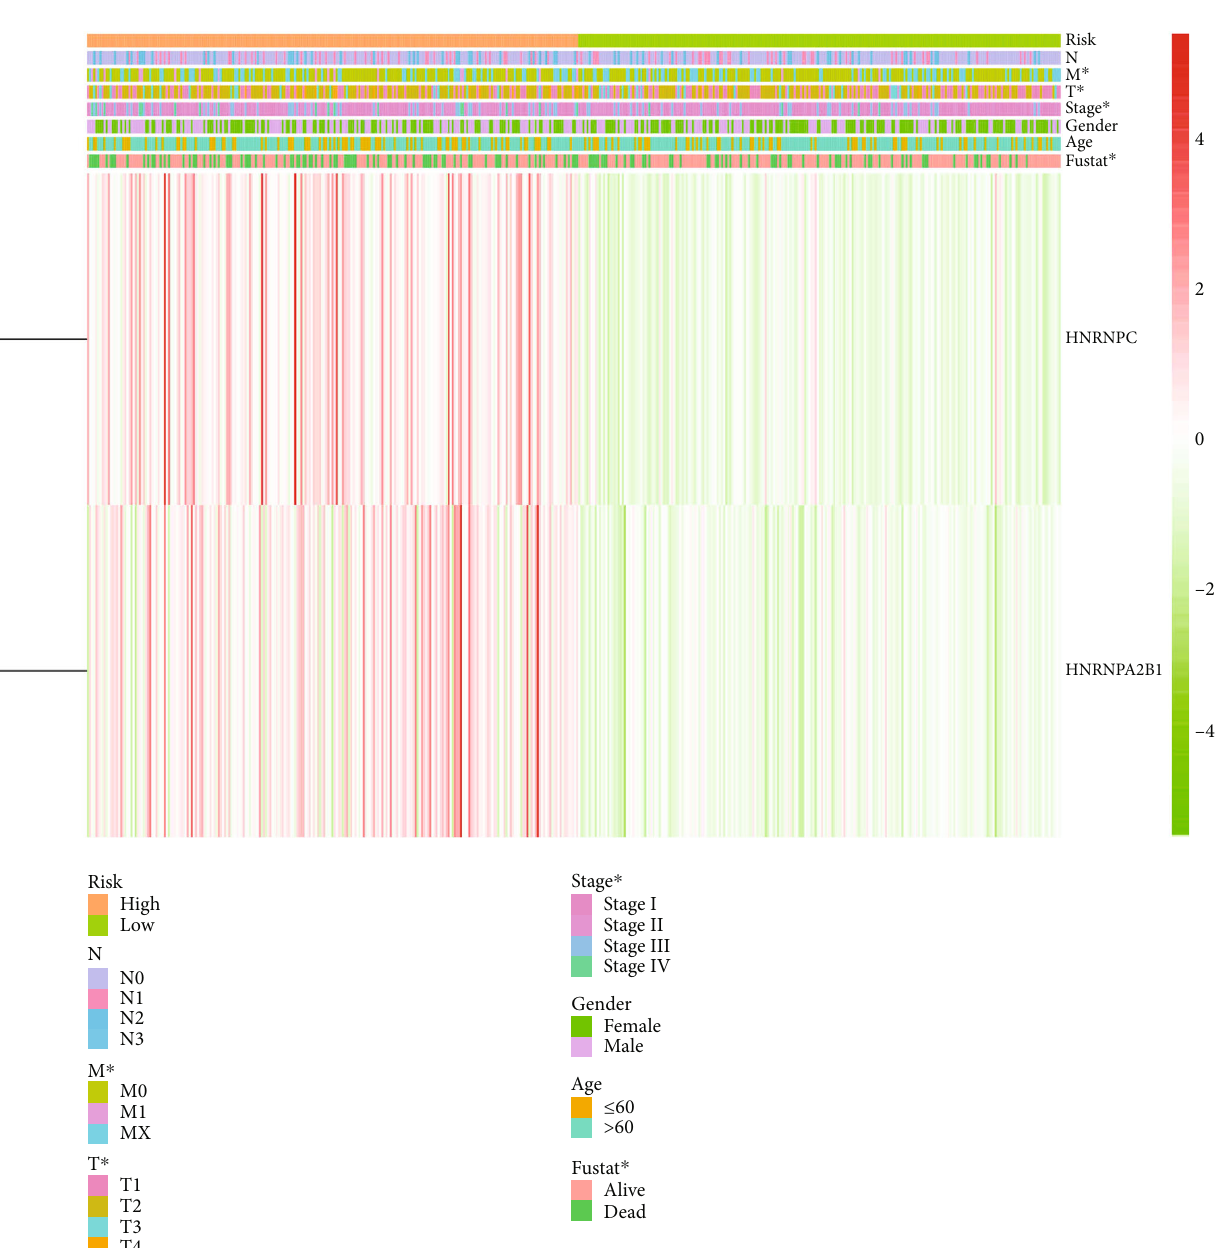
Figure 8: Heat map and clinicopathological features of high- and low-risk